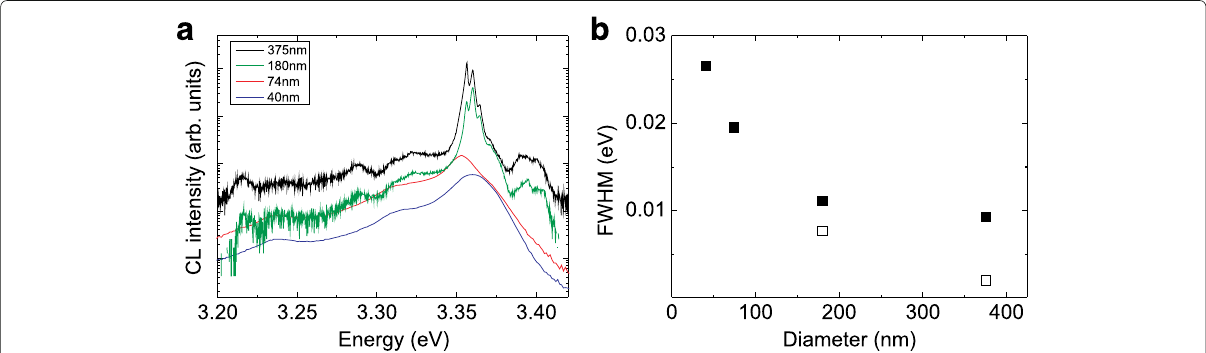
Fig. 5 a CL spectra of ZnO NWs for different diameters. For a better clarity, the spectra were shifted vertically. b Solidpoints —the FWHM from entire emission as a function of diameter of the NWs, emptypoints —the FWHM from the single peaks for thick NWs